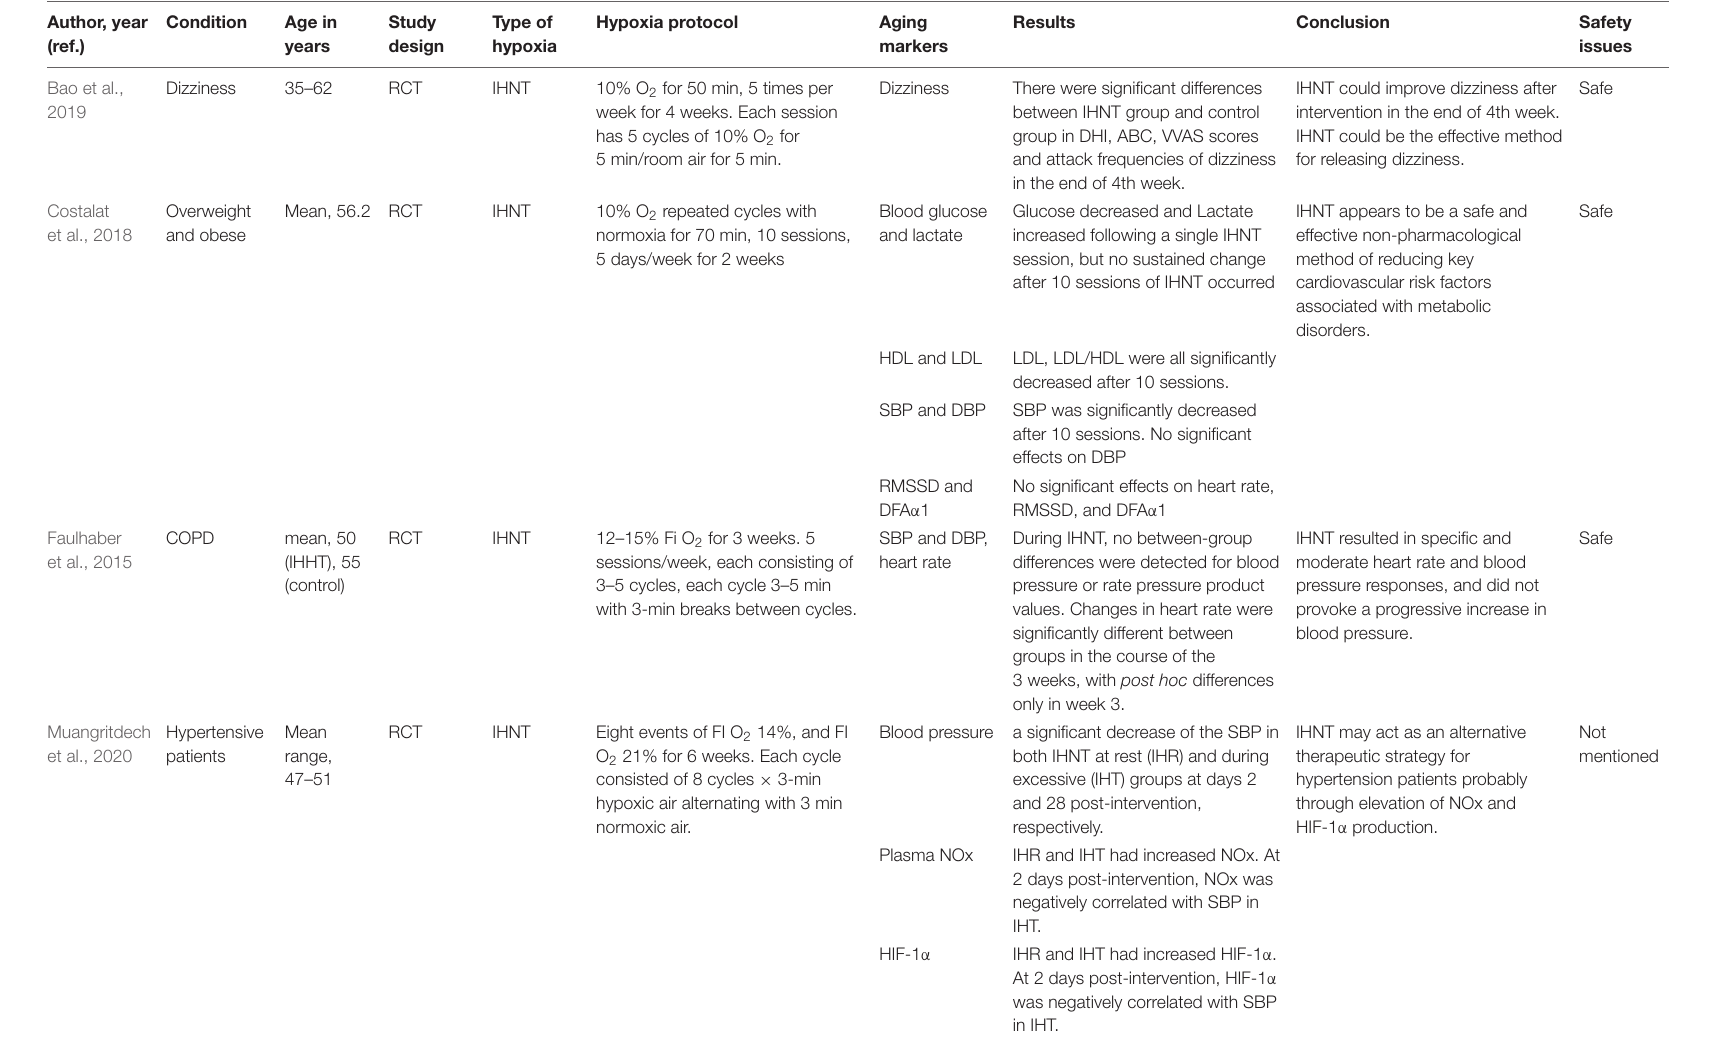
TABLE 1 | The effects of intermittent hypoxia-normoxia training (IHNT) on aging markers and age-related diseases. Author, year